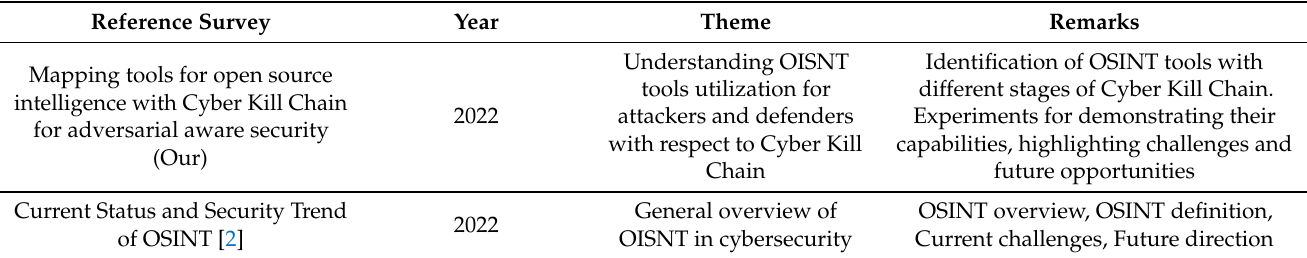
Table 1. OSINT survey paper